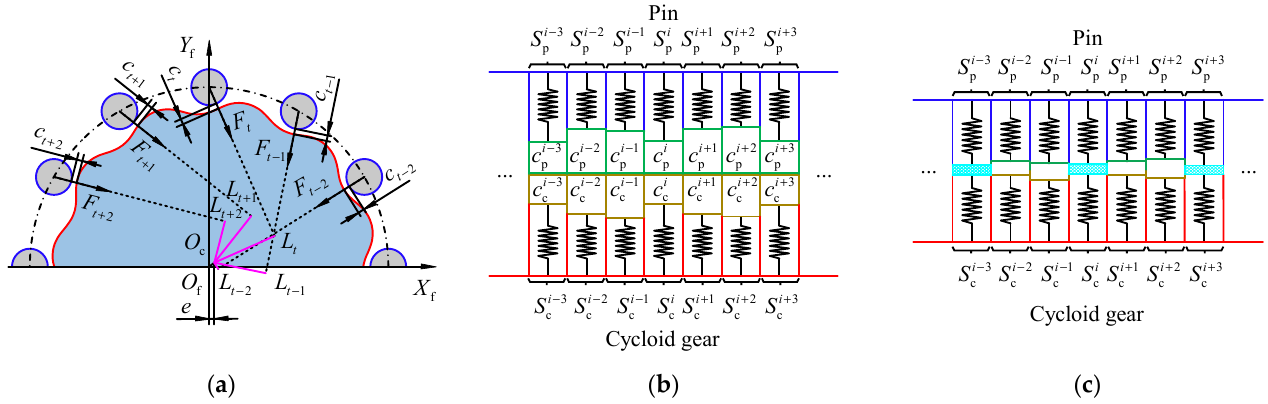
Figure 5. Tooth contact analysis: ( a ) tooth contact model of cycloid gear and pin, ( b ) initial position of each slice along tooth width, and ( c ) balance position of each slice along tooth width.